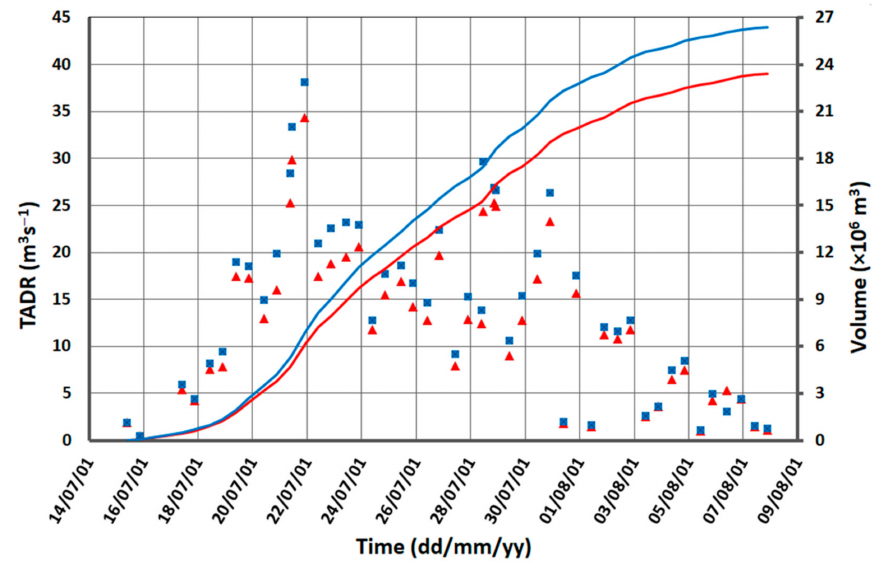
Figure 11. MODIS-derived TADR using a constant (‘TADR 1’, red triangles) and the multicomponent emissivity (‘TADR 2’, blue squares). The cumulative volumes are also reported (red curve for ‘TADR 1’, blue curve for ‘TADR 2’).